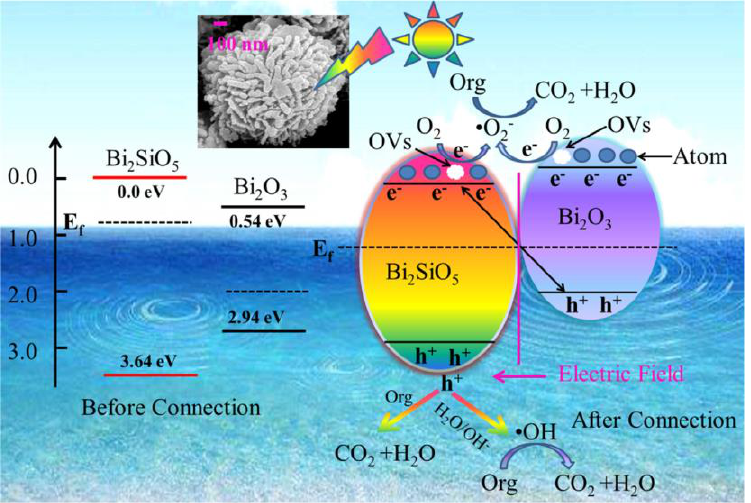
Figure 16. The photo-excited electron-hole separation process over OVs-Bi 2 O 3 /Bi 2 SiO 5 composite photocatalysts. Reproduced with permission from [164]. Copyright 2020 Elsevier.